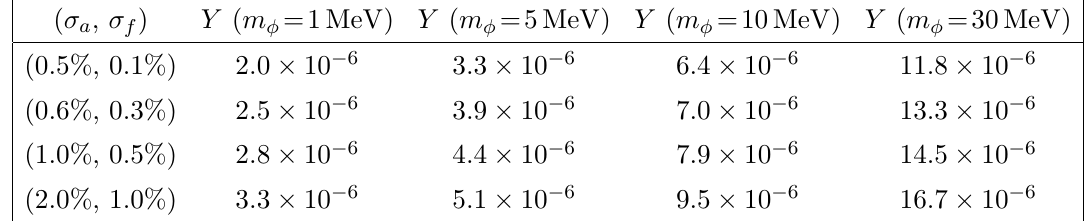
Table 1 . Uncertainties of the reactor neutrino (cid:13)ux assumed in CONUS100 and the corresponding bounds on Y